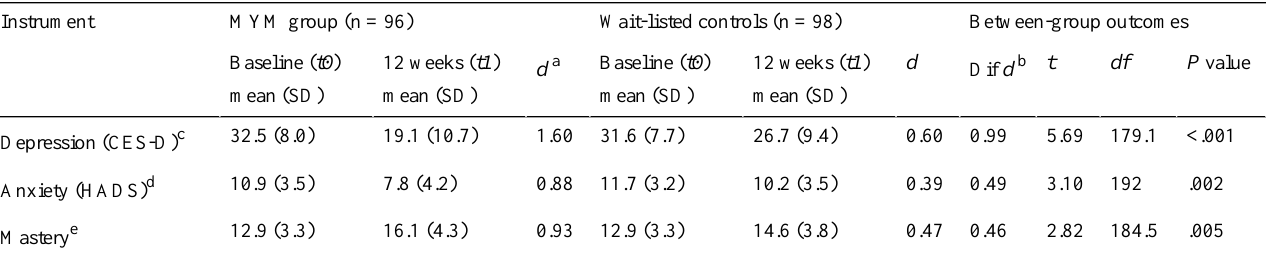
Table 4. Effects of Master Your Mood (MYM) course: comparison of responding participants only, no imputation.